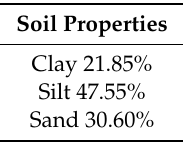
Figure 1. Location ( A ) and view ( B ) of the citrus orchard where the soil for the herbicidal tests was collected. Table 1. Physical properties of the soil used for the experiments